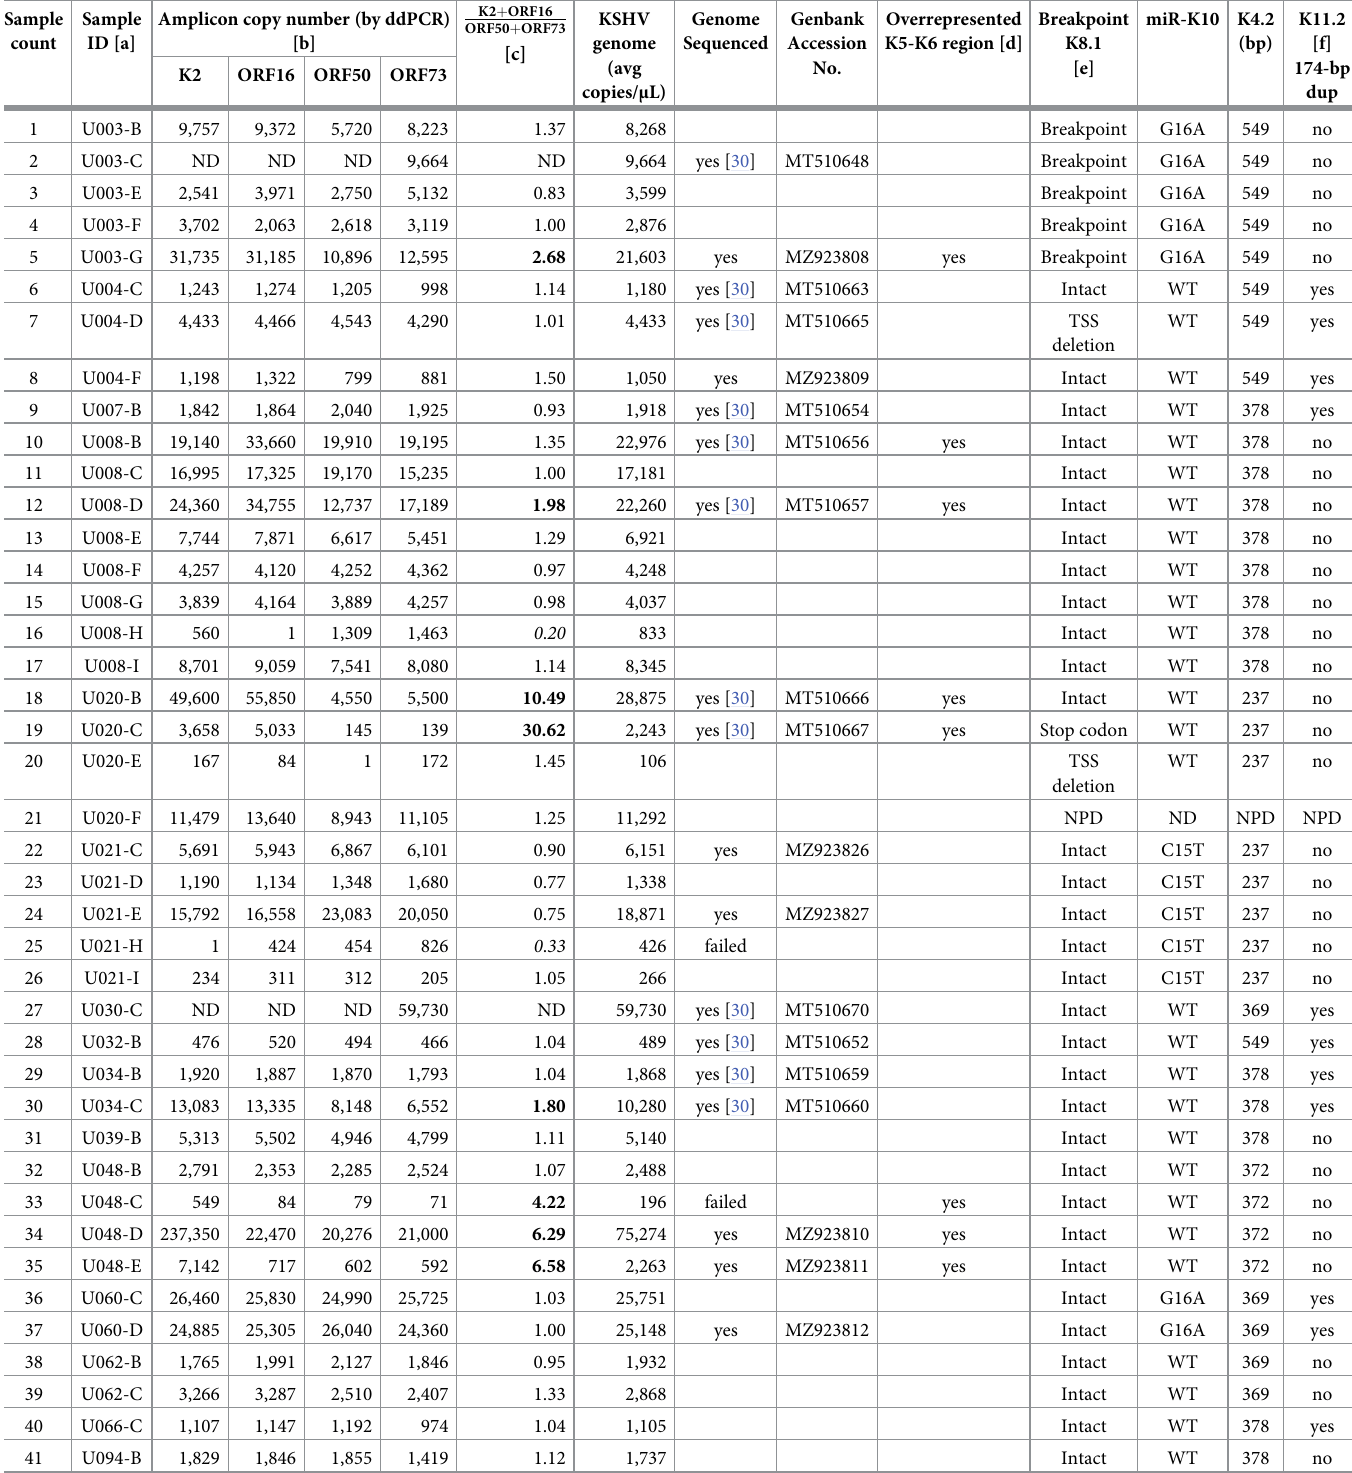
Table 2. KSHV genome characteristics in 65 KS tumors. Sample